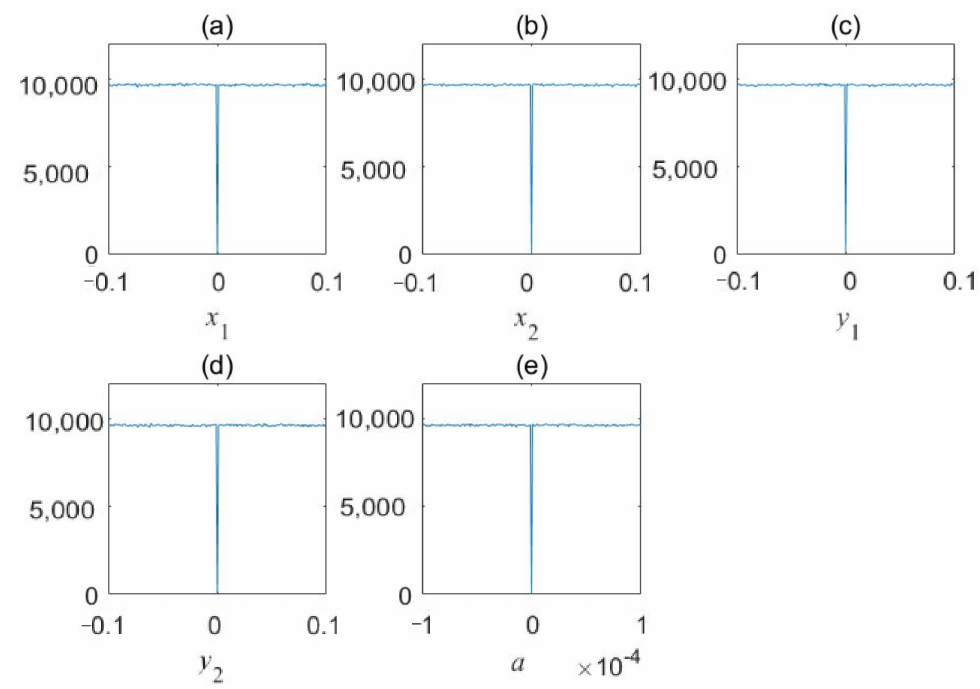
Figure 21. MSE analysis of decryption process of Baboon image: ( a ) x 1 ; ( b ) x 2 ; ( c ) y 1 ; ( d ) y 2 ; ( e ) a .